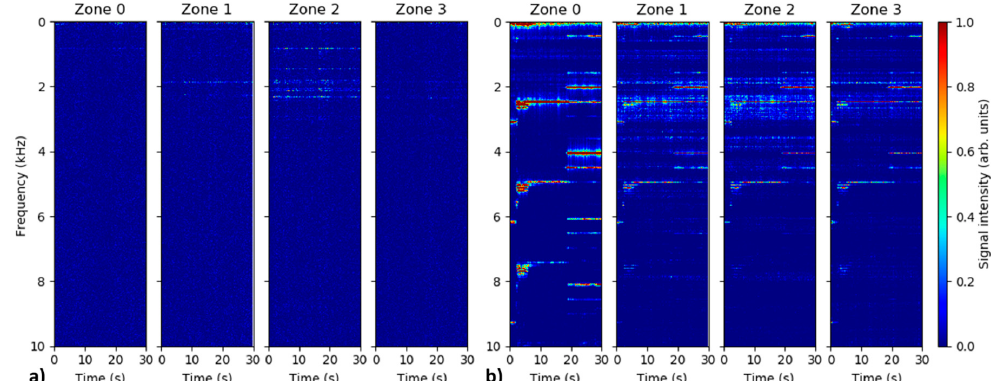
Figure 3. Temporal evolution of position-averaged distributed acoustic sensing (DAS) signal spectra in the individual pipe zones recorded for 1 mm leak at 10 bars ( a ) and 8 mm leak at 20 bars ( b ). Note that amplitude of spectra for 1 mm leak at 10 bars are scaled by factor 5 relatively to the spectra for 8 mm leak at 20 bars.